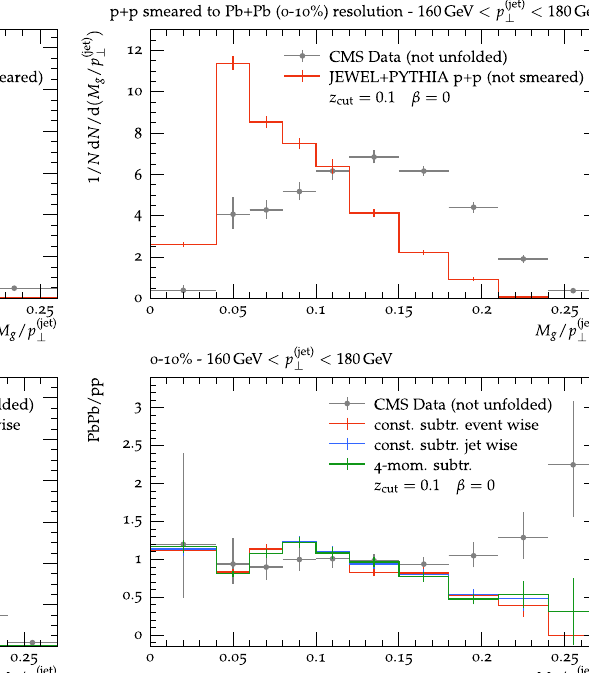
Fig. 5 Groomed jet mass divided by (un-groomed) jet p ⊥ distribu- tions for p+p (top left), p+p smeared to 0–10% Pb+Pb resolution (top right), 0–10% Pb+Pb (bottom left) and Pb+Pb (0–10%) divided by smeared p+p (bottom right). The SoftDrop parameters are z cut = 0 . 1 and β = 0 and the jets are anti- k ⊥ jets with R = 0 . 4, | η jet) | < 1 . 6 and